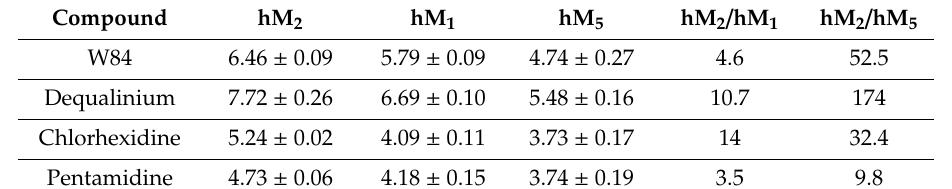
Table 5. A ffi nity estimates (log K occ ) at the [ 3 H]-NMS-occupied muscarinic hM 1 , hM 2 and hM 5 subtypes plus the corresponding selectivity ratios. Values reported as means of 3–4 experiments ± SEM.